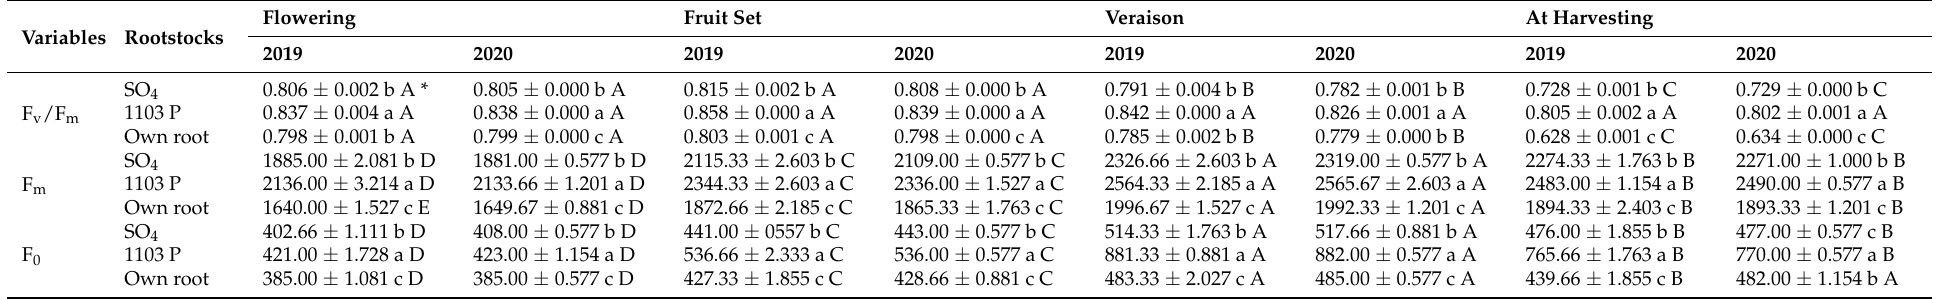
Table 1. The effect of rootstocks (SO 4 , 1103 Paulson, and own root) on chlorophyll fluorescence variables (F v /F m ratio, F m , and F 0 ) was determined four times during two growth seasons (2018–2019) on various berry developmental phases (flowering, fruit set, veraison, and at harvest time) of “superior seedless” vines.